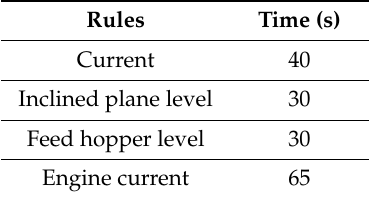
Table 5. Dynamic times, tertiary crushing.